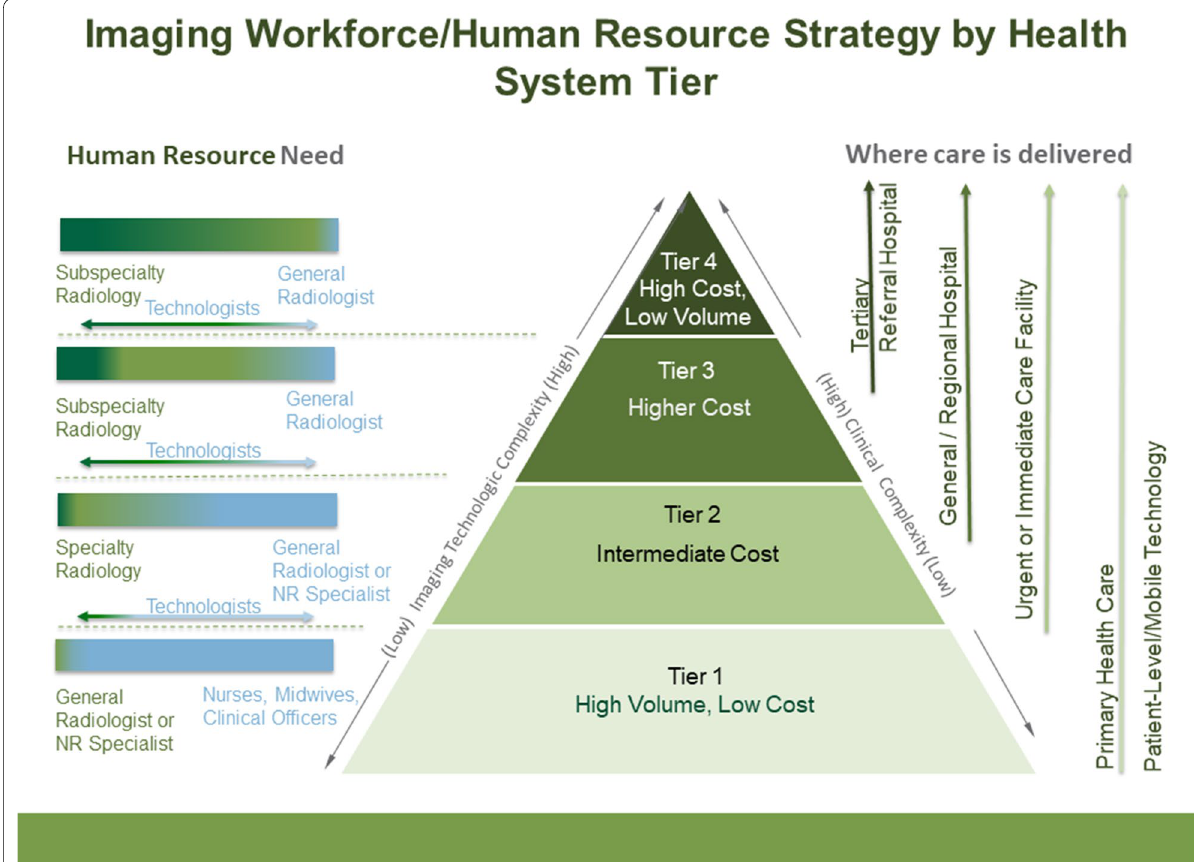
Fig. 4 Recommended imaging workforce/human resource strategy by health system tier. Higher levels on the pyramid denote increasing complexity and requirement for specialization of staff. Green denotes a requirement for higher‑level specialization or even sub‑specialization (e.g., neurointerventional radiology, oncologic imaging), while blue denotes lower‑level specialization. Technologists / radiographers are required at all tiers above primary care centers and may also have a role and primary care level even though not essential (NR technologists radiographic technologists, radiographers, =